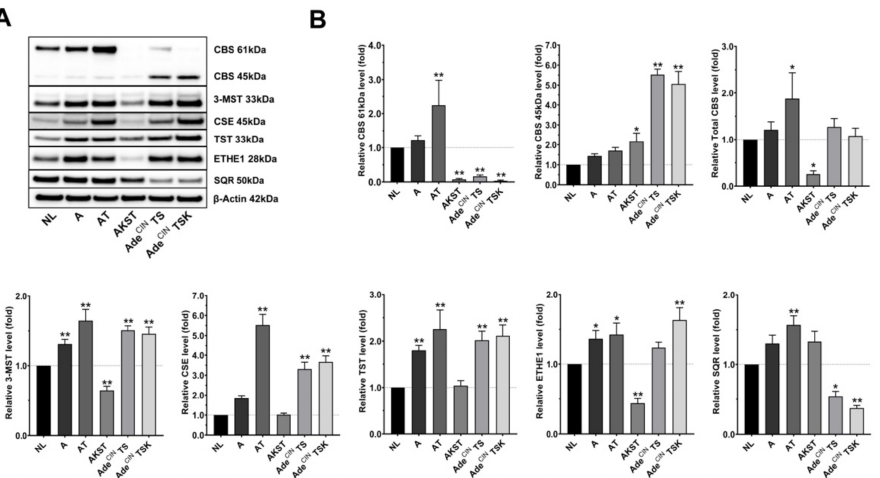
Figure 1. Upregulation of H 2 S-producing and H 2 S-metabolizing enzymes occurs during the ac- cumulation of ‘driver’ pathway mutations in human intestinal epithelial cell organoids. Western blot analysis ( A ) and densitometric quantification ( B ) of H 2 S-producing (CBS, 3-MST, CSE) and H 2 S-metabolizing (TST, ETHE1, SQR) enzymes in NL, A, AT, AKST, Ade CIN TS and Ade CIN TSK organoids after 7 days in culture. Data represent mean ± SEM of at least 5 independent